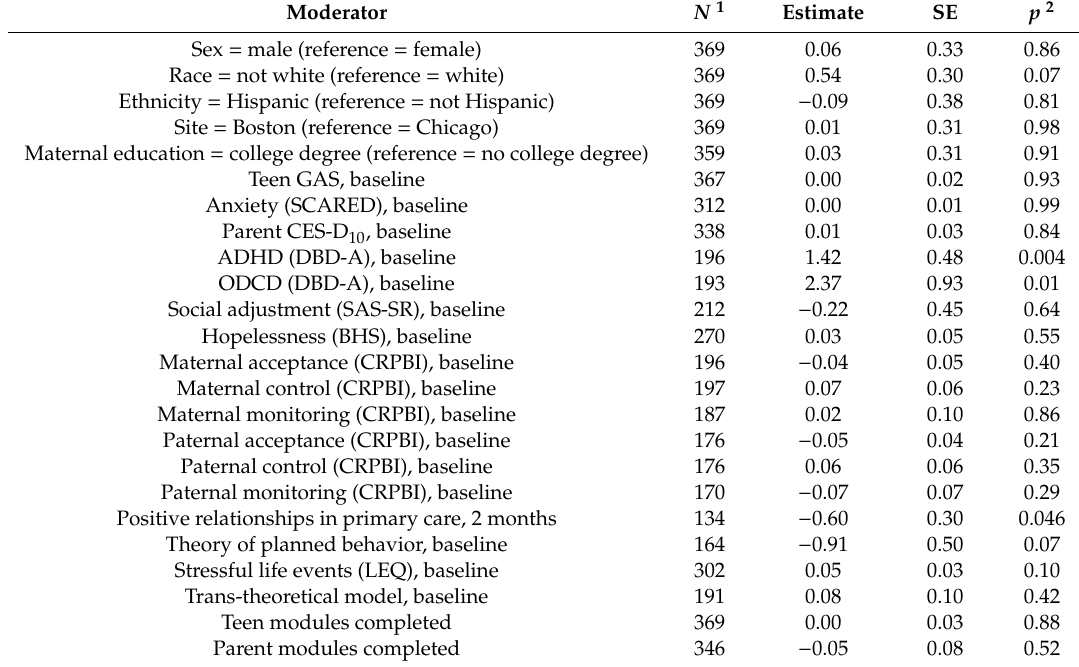
Table 3. Summary of moderator analyses for CESD: Group*Visit*Moderator Interaction